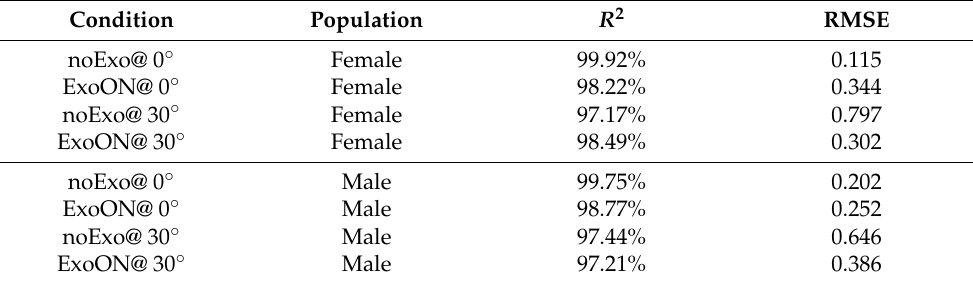
Figure 7. Interpolation trend of 90th percentile of both ES muscular activation with and without the exoskeleton at 30 ◦ inclination for the four load conditions. Table 5. RMSE and R 2 values of the linear